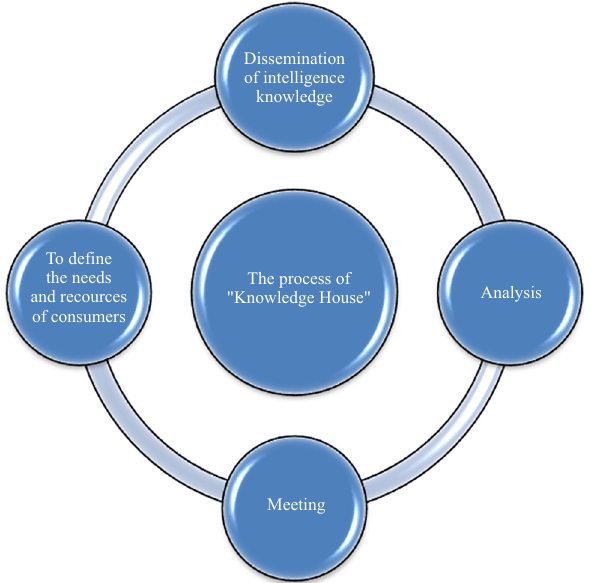
Fig. 1. The process of application of the method “Knowledge House” Source : created by authors according to Polak